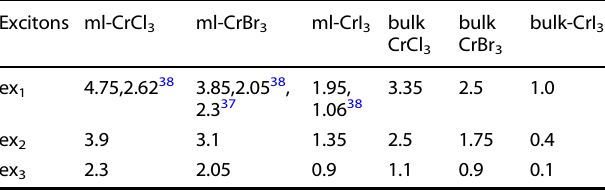
Table 2. Exciton-binding energies in bulk and